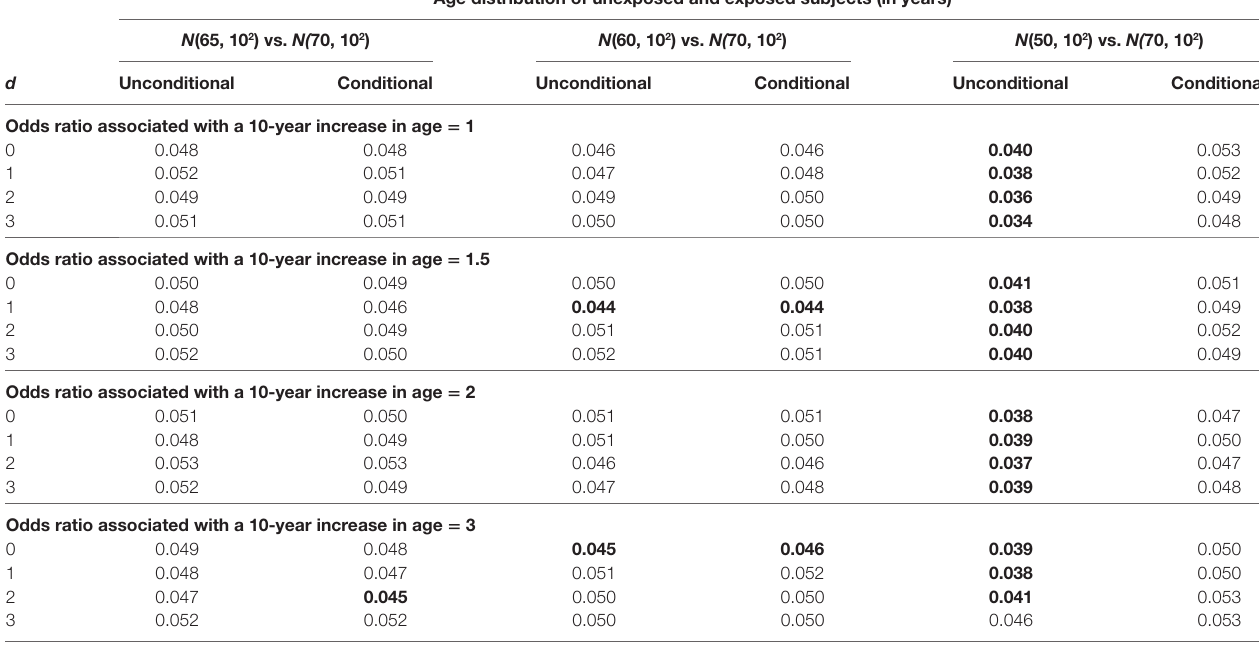
Table 1 | Type I errors of unconditional and conditional logistic regression models. age distribution of unexposed and exposed subjects (in